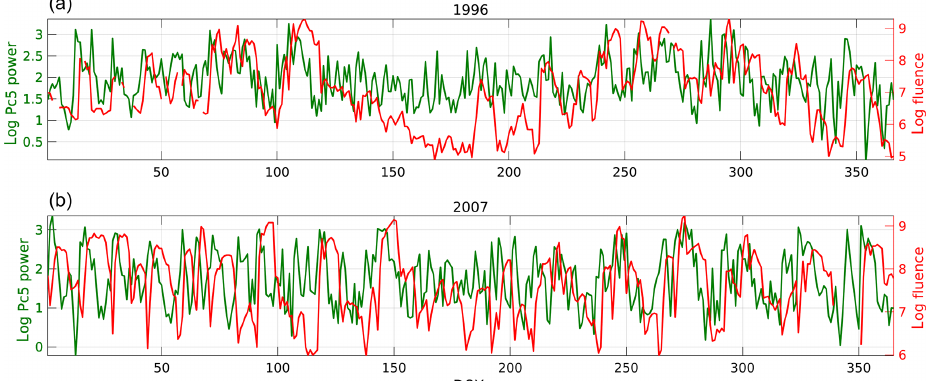
Figure 2. Fluence (red curve) and Pc5 power (green curve) values in 1996 (a) and 2007 (b) . The peaks and valleys of Pc5 power and fluence seem to follow each other closely, especially in